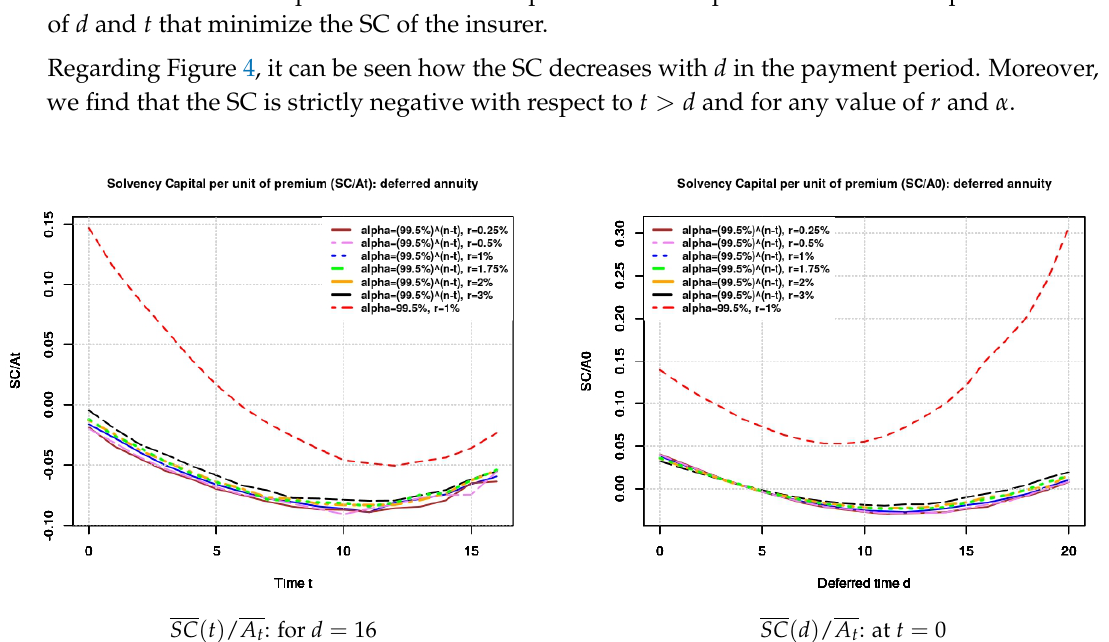
Figure 3. Deferred annuity; SC ( t ) and SC ( d ) respectively for different values of the short rate r and α on the deferred